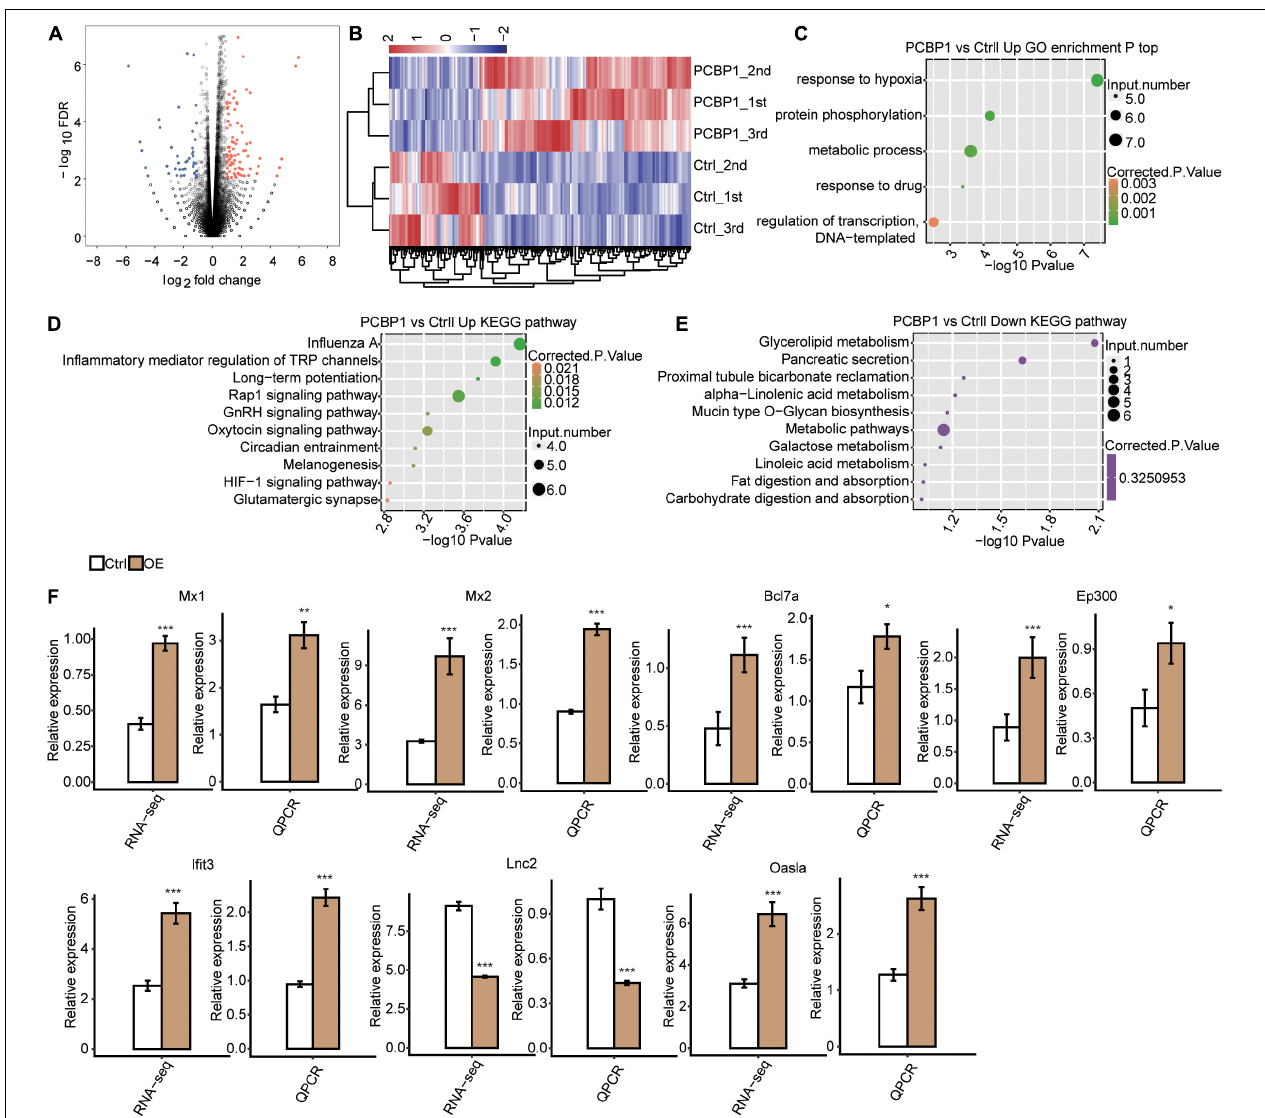
FIGURE 2 | RNA-seq analysis of PCBP-1 regulated transcriptome profile. (A) Identification of PCBP-1 regulated genes. Up-regulated genes are labeled in red, down-regulated ones are in blue in the volcano plot. (B) Hierarchical clustering of DEGs in PCBP1-OE and control samples. FPKM values were log2-transformed and then median-centered by each gene. (C) The top 10 representatives GO biological processes pathways for up-regulated genes. (D) The top 10 representative KEGG pathways for up-regulated genes. (E) The top 10 representative KEGG pathways for downregulated genes. (F) Inflammatory response-related gene expression regulation by PCBP-1. Error bars represent mean ± SEM. * P < 0.05, ** P < 0.01, *** P <